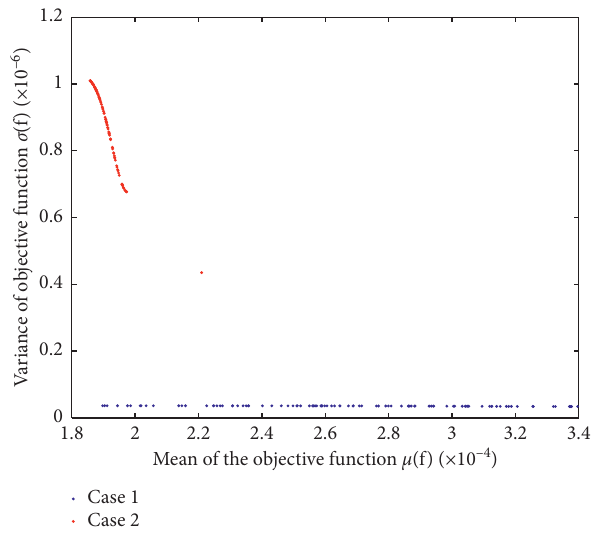
Figure 9: Pareto fronts of multiobjective optimization under the two